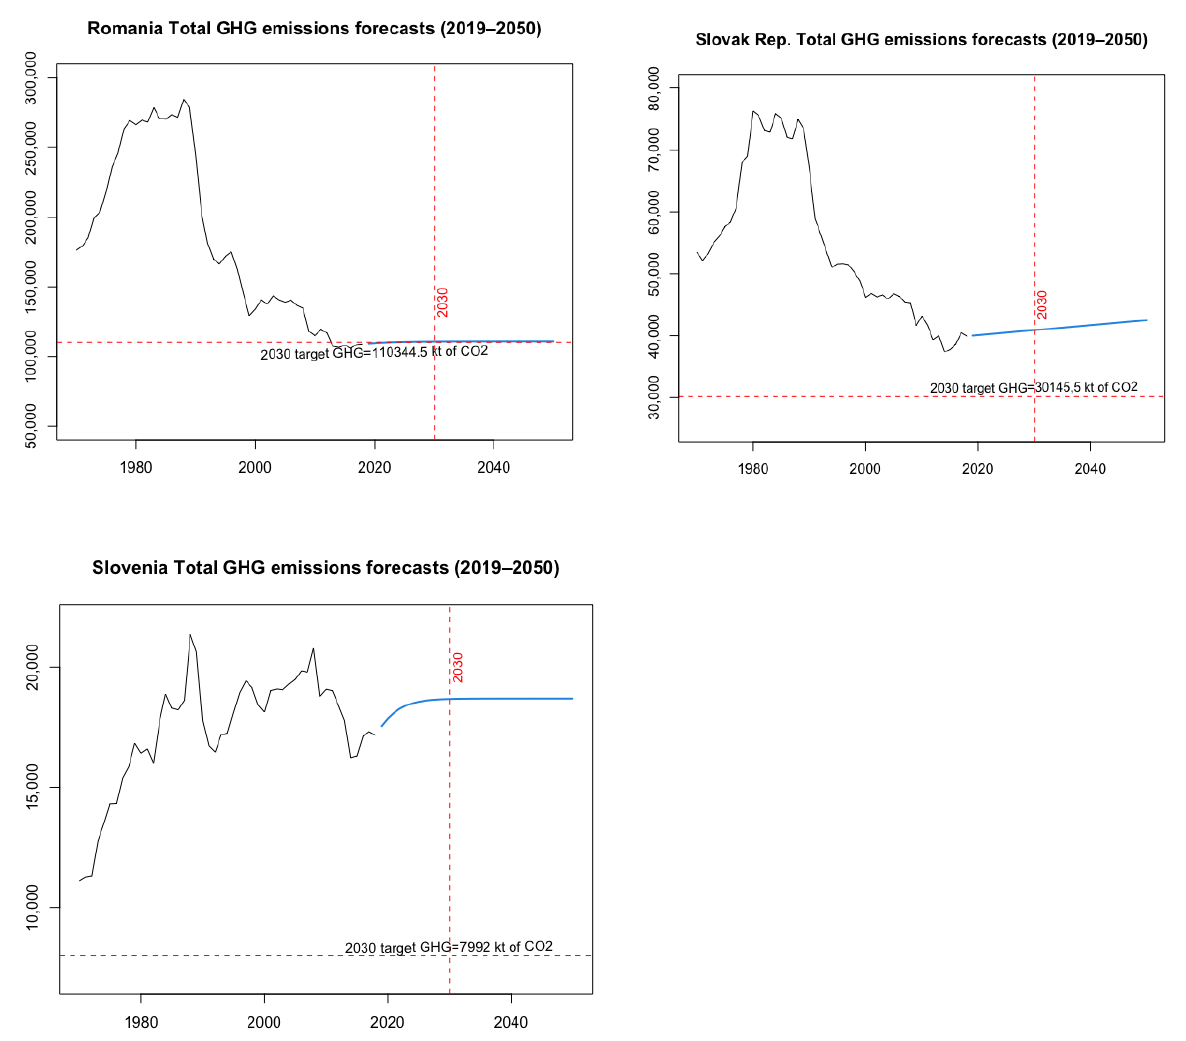
Figure 8. GHG forecasts with the best-performing predictive model for each country (actual target values for 2030 are also highlighted). Source: estimation results.